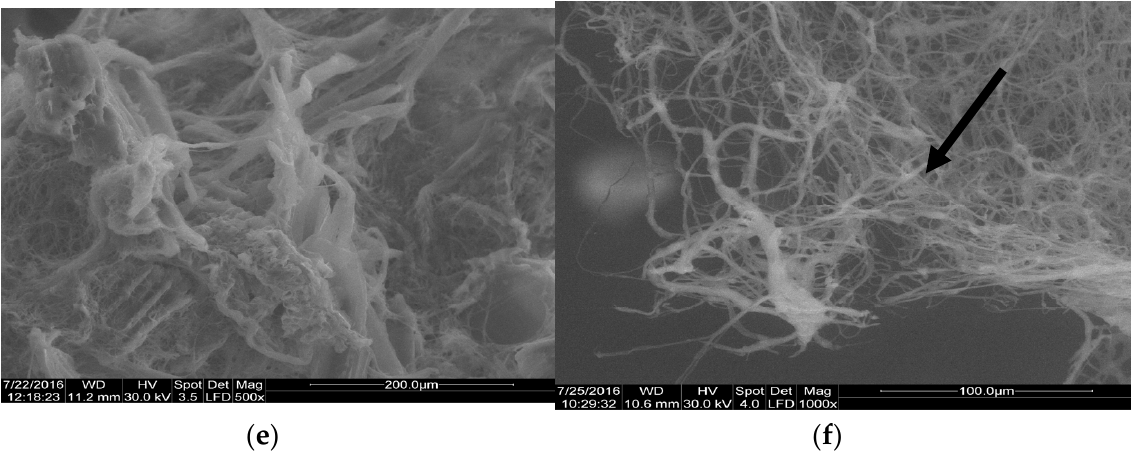
Figure 7. SEM images of Ganoderma lucidum cultured on lignocellulosic substrate (wheat straws) and polypropylene embedded with bacterial spores. ( a ) Fungal hyphae (black arrow); ( b ) Mycelium (black arrow); wheat straw structure (dotted black arrow); conidia (white arrow) (500 × ); ( c ) Wheat straw structure (black dotted arrow); conidia (white arrow) (2000 × ); ( d ) Fungal mycelium attached to wheat straw (black arrow); degradation of wheat straw (white dotted arrow) (300 × ); ( e ) Ribbons or tubular hyphae from mycelium growing on substrate (500 × ); ( f ) Aerial mycelium detached from substrate (black arrow) (1000 × ).